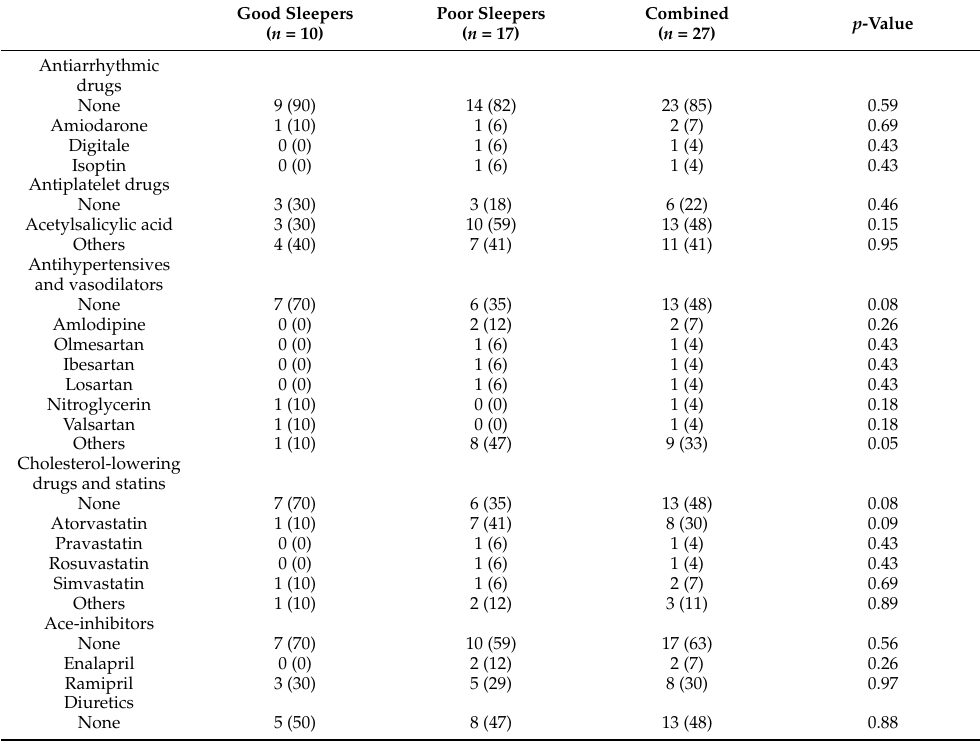
Table 2. Pharmacological therapy. Data are reported as absolute numbers (percentage). Good sleepers are subjects with a Global PSQI Score equal to or less than 5 points, Poor sleepers are subjects with a Global PSQI Score higher than 5